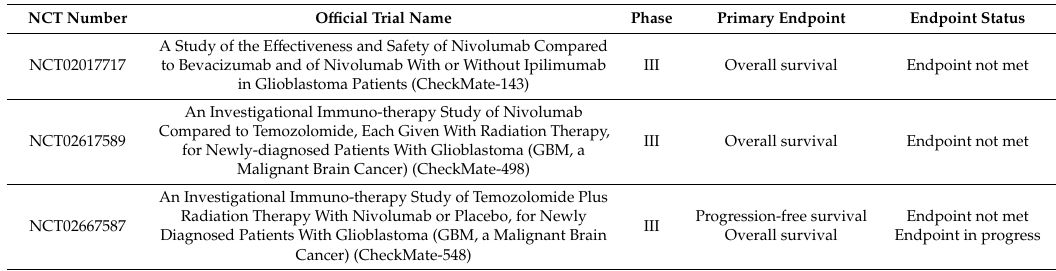
Table 4. Important studies with immune checkpoint inhibitors in newly-diagnosed and recurrent glioblastoma awaiting publication.